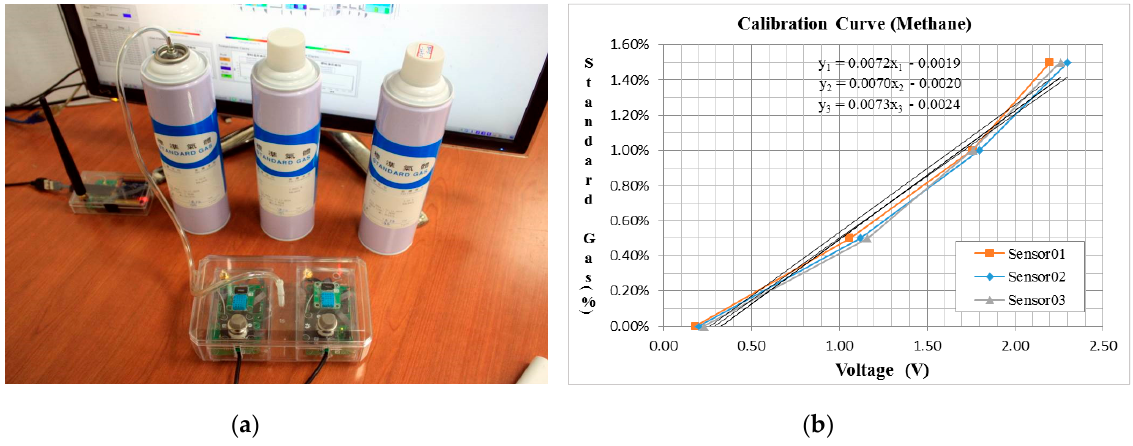
Figure 13. The calibration of sensor nodes, ( a ) Calibration by different concentration standard methane gases; ( b ) Relational curves of gas concentrations and measured voltages.